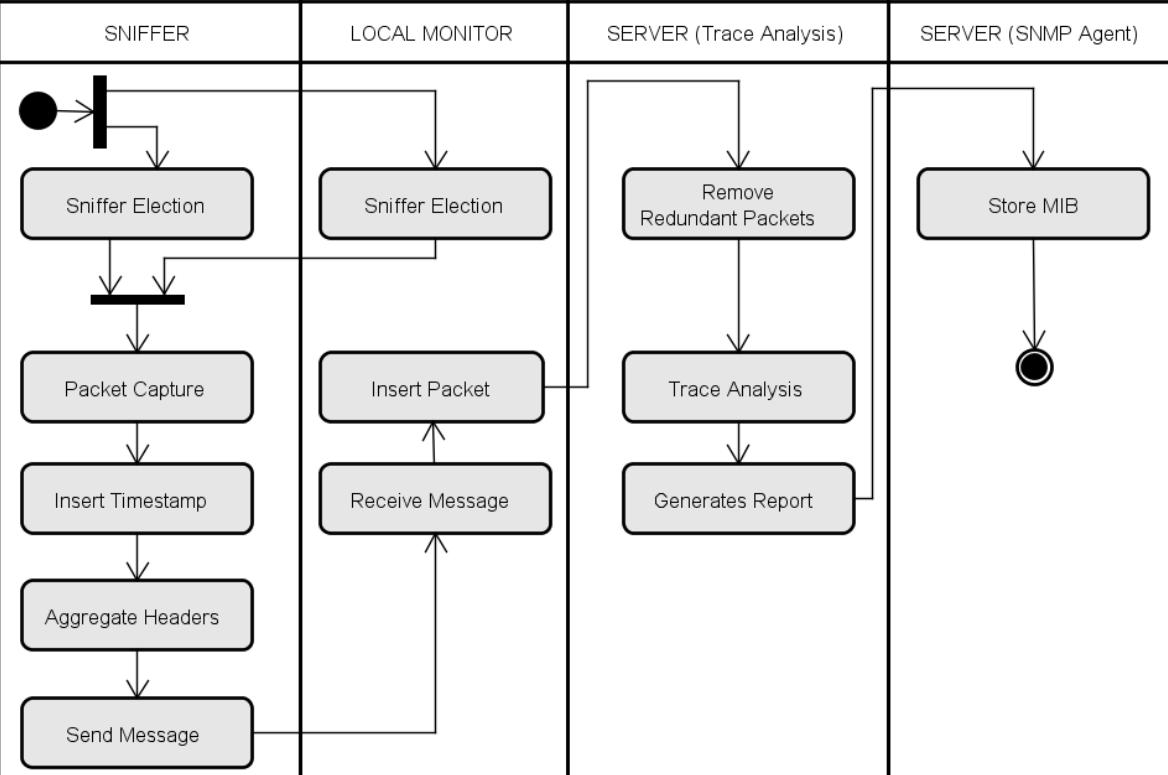
Figure 2. UML activity diagram of the